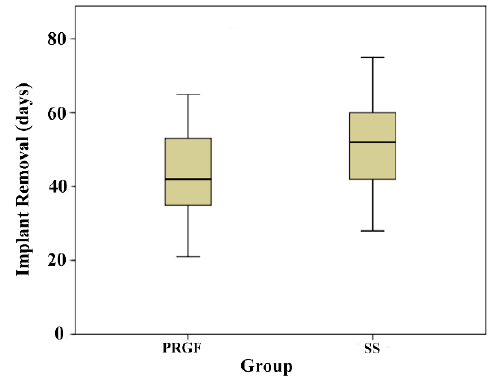
Figure 1. Boxplot corresponding to the days of implant removal for both PRGF and SS groups. Mean time was significantly higher in the SS group.